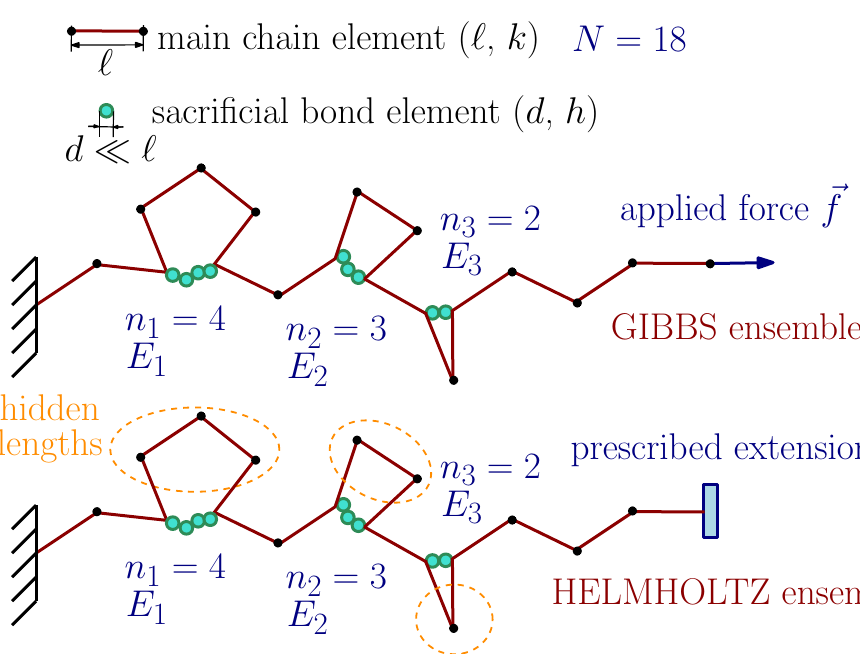
Figure 1. Simplified sketch of a polymer chain or macromolecule with sacrificial bonds. The main chain is composed of N . elements with the equilibrium length (cid:96) and elastic constant k . Each sacrificial bond is composed of n j elements with equilibrium length d (cid:28) (cid:96) and elastic constant h , and is characterized by fracture energy E j (where j = 1,..., s , with s being the number of sacrificial bonds). The chain is studied within the Gibbs ensemble (with an applied force) and within the Helmholtz ensemble (with prescribed extension). The main chain elements short-circuited by the sacrificial bonds correspond to the hidden lengths of the